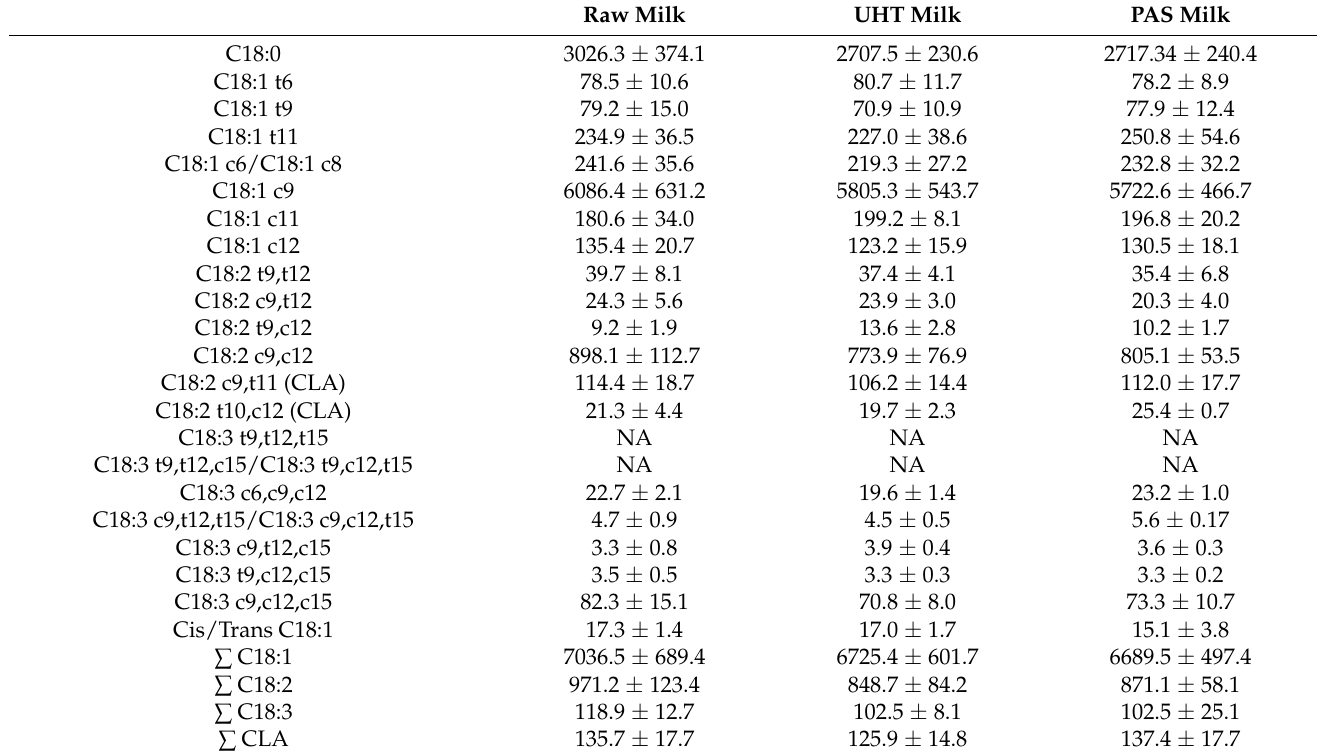
Table 4. C18 FAs content in raw milk ( n = 20), PAS milk ( n = 15), and UHT milk samples ( n =